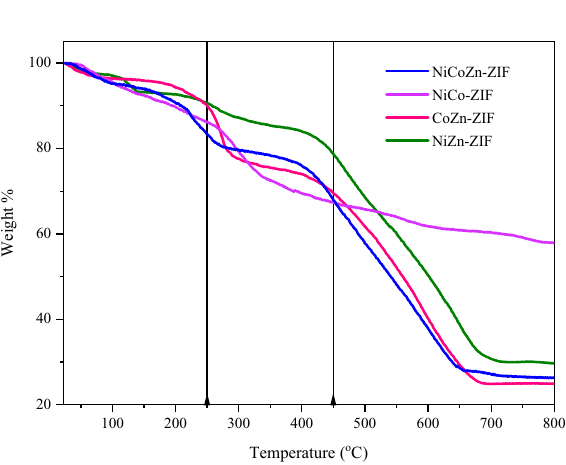
Figure 7. TGA analysis of as prepared NiZn-ZIF, CoZn-ZIF, NiCo-ZIF and